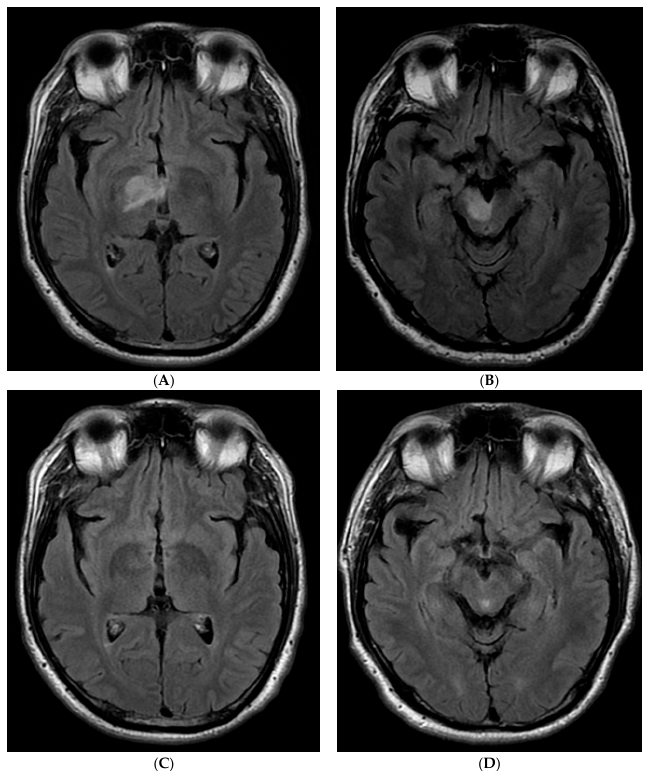
Figure 1. Selected magnetic resonance imaging (MRI) T2/fluid-attenuated inversion recovery (FLAIR) imaging from initial ( A , B from Jan 2017) and last ( C , D from May 2017) MRI. Neurol. Int. 2020 , 12 , FOR PEER REVIEW